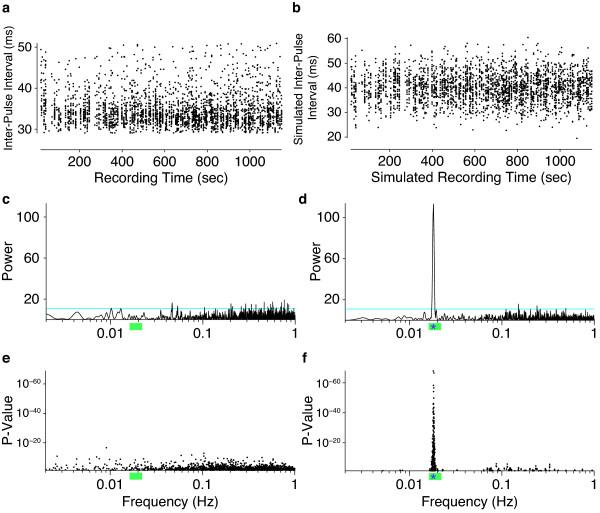
Statistical analysis of rhythms in the inter-pulse interval. (a) An example of inter-pulse intervals produced by a single individual during a single recording session. (b) An example of simulated inter-pulse intervals with a periodicity of 0.018 Hz, a SNR = 1, and sampling times derived from the data in panel a. (c,d) The Lomb-Scargle periodograms for the real data shown in panel a (c) and for the simulated data shown in panel b (d). Horizontal cyan lines indicate power where P = 0.05. (e, f) P-values of the local peaks in the Lomb-Scargle periodograms of inter-pulse interval for all 75 recordings of D. melanogaster (e) and for all 75 simulated datasets with a SNR = 1 (f) over the range of 0 to 1 Hz. Only P-values below 0.05 are plotted. The green bars below the axes in c-f mark the range of 0.016 to 0.22 Hz, which is the reported range of rhythms in the inter-pulse interval [9,21-23,46]. The asterisks within the green bars in d and f indicate 0.018 Hz, the frequency used in these simulations. The naturally skewed distribution of the real data, for example in panel a, differs from the distribution in the simulated data. We found, however, that culling the data to generate Gaussian distributed inter-pulse interval data resulted in even fewer significant peaks in the periodograms than shown in panel e and no obvious clustering of peaks in any particular frequency range (not shown). SNR: signal-to-noise ratio.